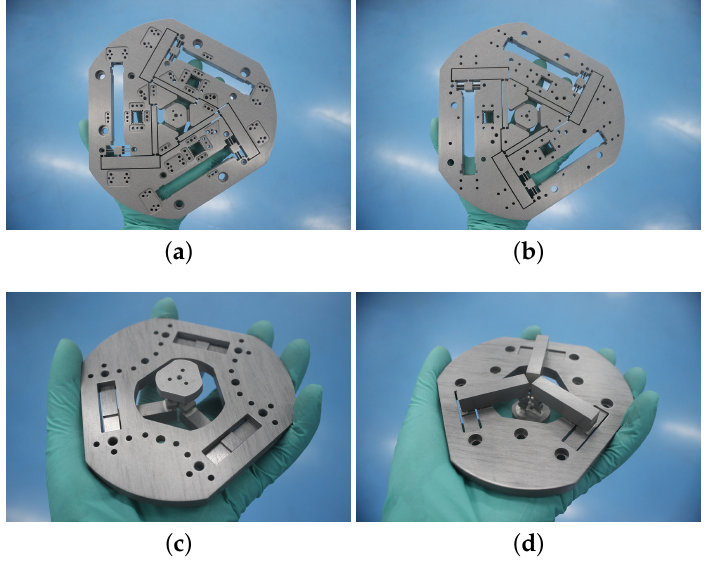
Figure 15. Fabricated prototypes of the two-in-one 6-RRRR CPM. ( a ) In-plane 3-RRRR CPM; ( b ) bottom-to-up view; ( c ) out-of-plane 3-RRRR CPM; ( d ) bottom-to-up view.